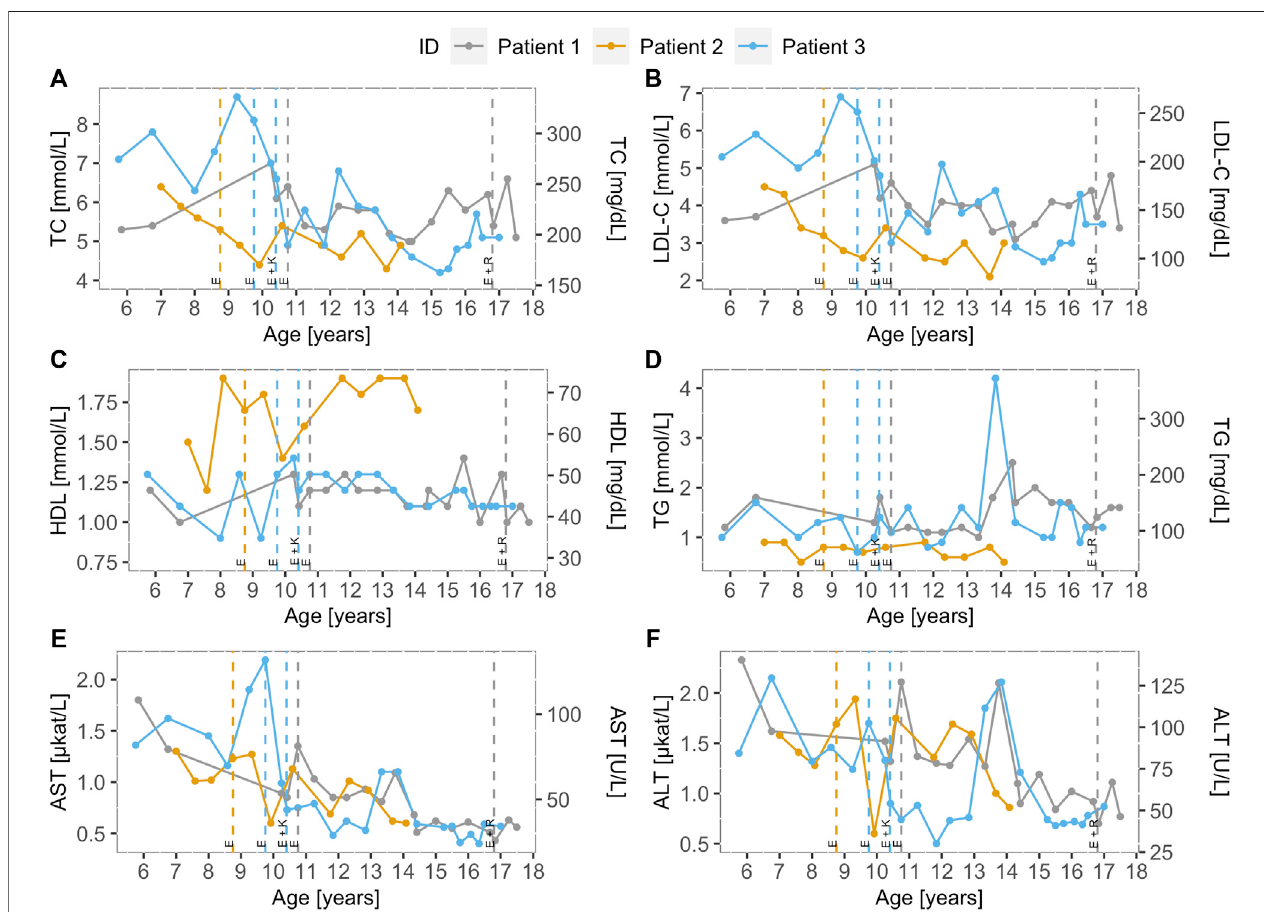
FIGURE2| LipoproteinandtransaminaselevelsoftheLAL-Dpositivechildrenovertime.Distributionof (A) totalcholesterol, (B) low-densitylipoproteincholesterol, (C) high-density lipoprotein cholesterol, (D) triglycerides, (E) aspartate transaminase, and (F) alanine transaminase for LAL-D-positive population over time. Dotted vertical lines represent the beginning of the treatment and treatment modi fi cation for each patient. All three patients were treated with ezetimibe (10 mg). Furthermore, patient 3 was treated with a combination of ezetimibe (10 mg) and Kanuma ® and patient 1 was treated with a combination of ezetimibe (10 mg) and rosuvastatin (10 mg) from the age of 16, but the combination therapy was discontinued because of fatigue. LDL-C: low-density lipoprotein cholesterol; TC: total cholesterol; HDL-C: high-density lipoprotein cholesterol; TG: triglycerides; AST: aspartate transaminase; ALT: alanine transaminase; E: Ezetimibe (10 mg), K: Kanuma (40 mg), R: Rosuvastatin (10